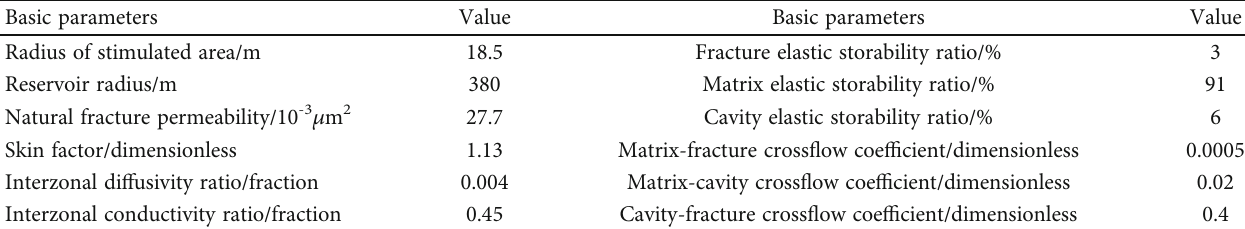
Figure 16: Fitting of monitoring data of CT-2 with new type rate decline curves. Table 4: Fitting results of relevant parameters for